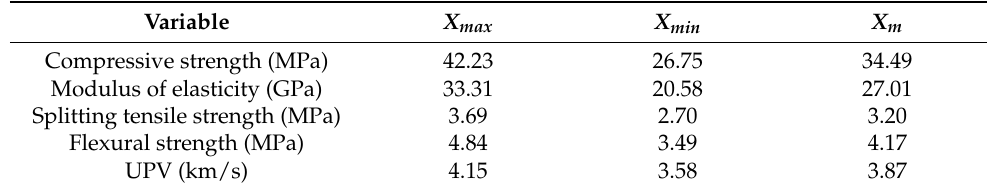
Table 4. Values for the standardization of the UPV readings and the mechanical properties. Variable X max X min X m Compressive strength